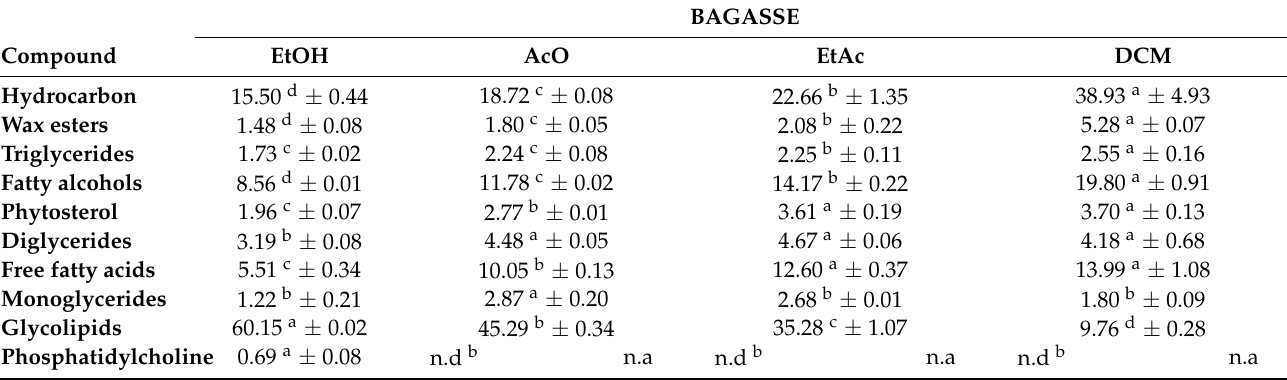
Table 2. Lipid classes composition (g/100 g of lipids) of different sugarcane bagasse extracts.